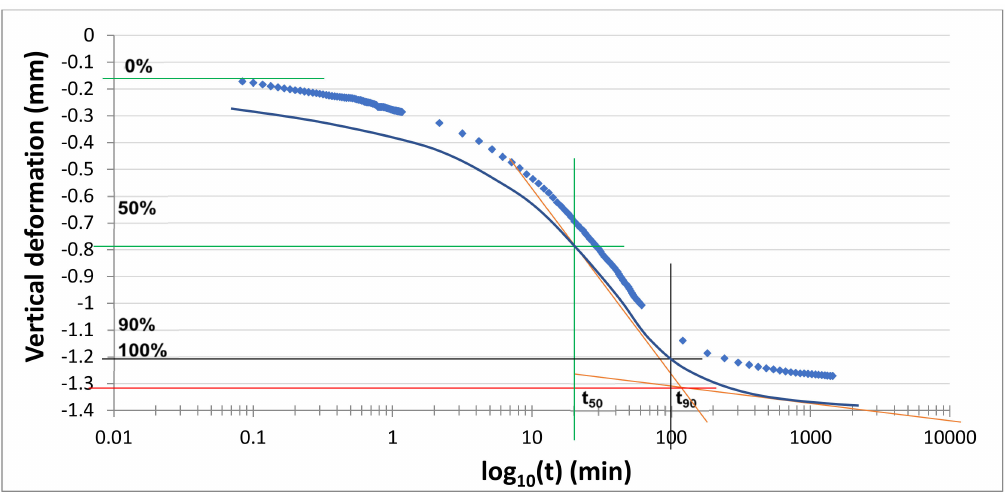
Figure 7. Consolidation curve of loading step 8 (high content muscovite